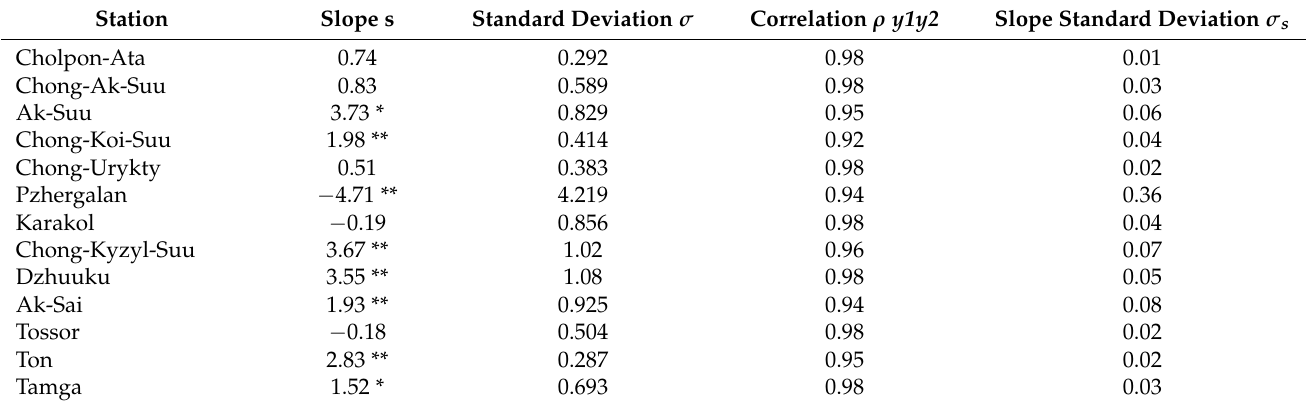
Table 3. Analysis of ITA (slope s) of annual river runoff in the study area (1943–2012).